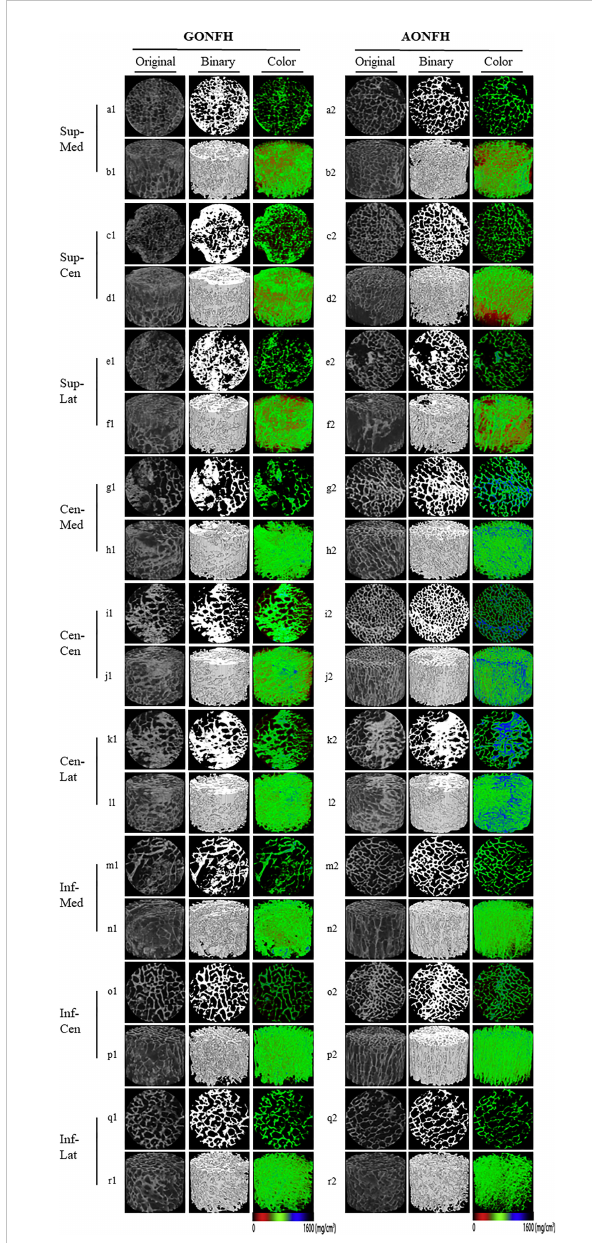
FIGURE 4 Representative original, binary and color micro-CT images of different ROIs in the femoral head from patients with GONFH (a1-r1) and patients with AONFH (a2-r2). 2D visualization of the cross- section of the Sup-Med (a1, a2) , Sup-Cen (c1, c2) , Sup-Lat (e1, e2) , Cen-Med (g1, g2) , Cen-Cen (i1, i2) , Cen-Lat (k1, k2) , Inf-Med (m1, m2), Inf-Cen (o1, o2), and Inf-Lat (q1, q2); 3D reconstruction of the Sup-Med (b1, b2) , Sup-Cen (d1, d2) , Sup-Lat (f1, f2), Cen-Med (h1, h2) , Cen-Cen (j1, j2) , Cen-Lat (l1, l2) , Inf-Med (n1, n2), Inf-Cen (p1, p2), and Inf-Lat (r1, r2). The color images represented mineralization distribution in trabecular bone. Red, green and blue represent low, intermediate and high mineral density,